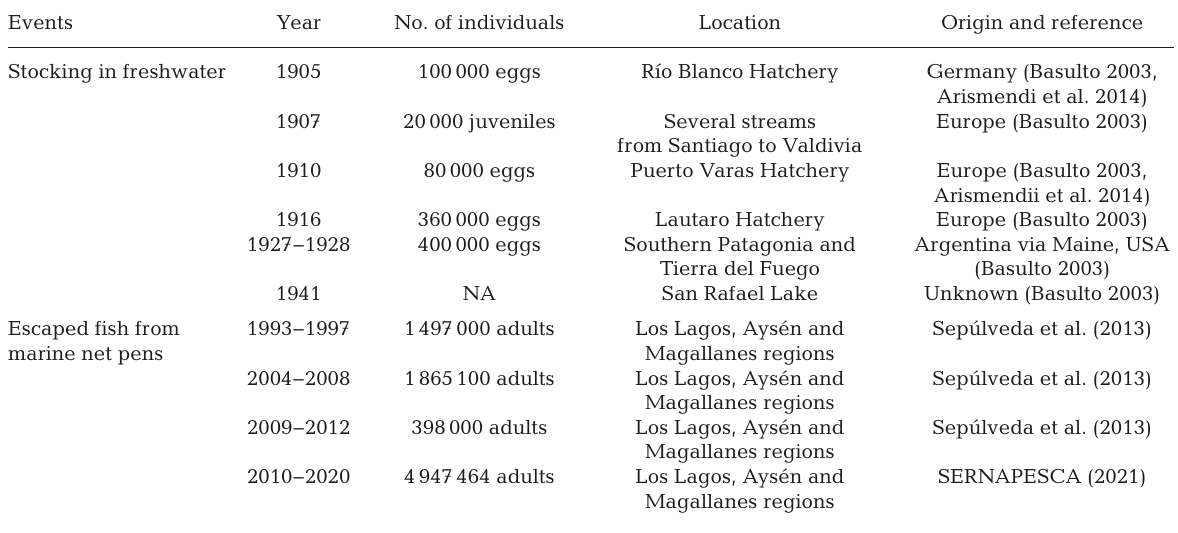
Table 1. Introduction events of Atlantic salmon, including stocking in freshwater and records of escapes from marine net pens in Chile. NA: not